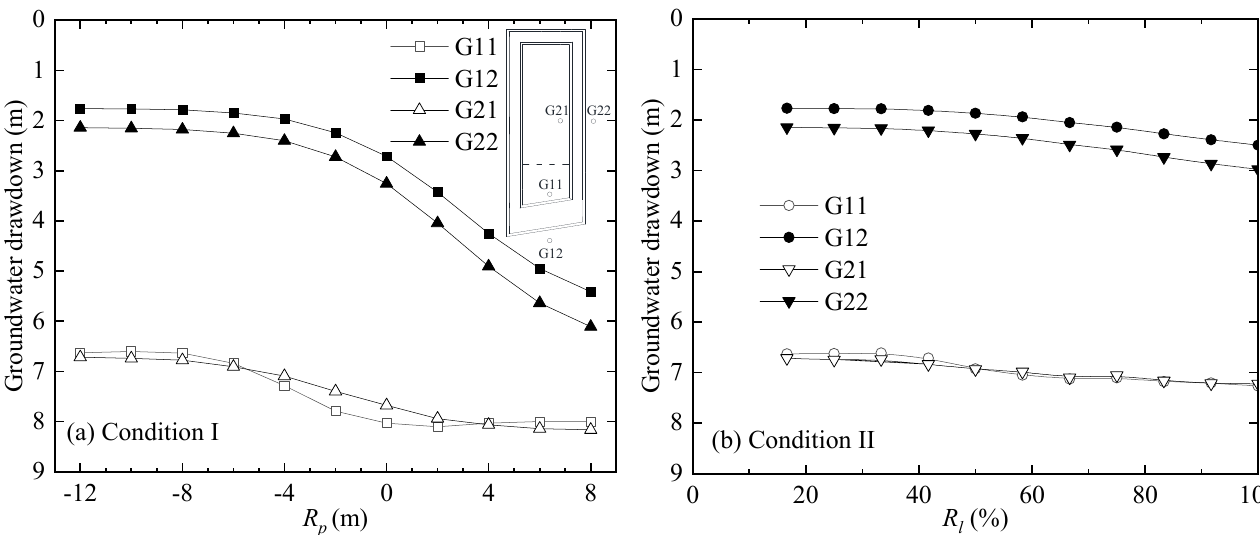
Figure 10. Groundwater drawdown on two sides of the waterproof curtain in different calculation cases : ( a ) Condition I; ( b ) Condition II .